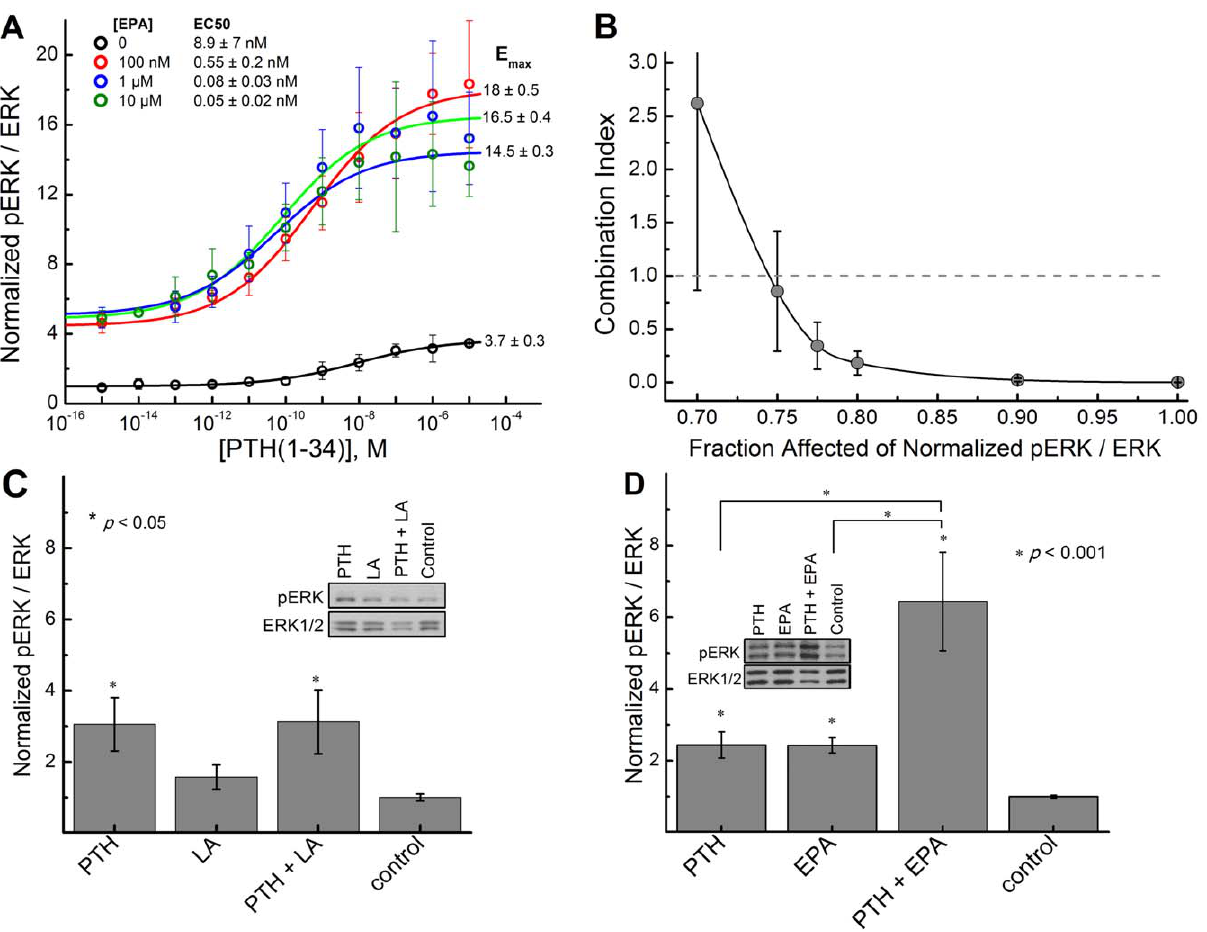
Figure 3. EPA modulates efficacy of PTH(1–34) on ERK1/2 activation. (A) EPA increases the efficacy of PTH(1–34) activation in HEK293 cells. Experiments were done 24 h after transfection of HEK293 cells with PTH1R in 12-well plates. (B) Formal synergy analysis was quantified by combination index analysis versus magnitude of the effect. Combination index values that are less than 1 indicate synergistic interaction. (C) 10 nM PTH(1–34) did not increase the efficacy of 1 m M Linoleic Acid in PTH1R transfected HEK293 cells. (D) 10 nM PTH(1–34) increases the efficacy of 1 m M EPA activation in MC3T3-E1 cells expressing endogenous PTH1R. Ratio of pERK to ERK was measured using western blots. Data represents the mean of at least four independent